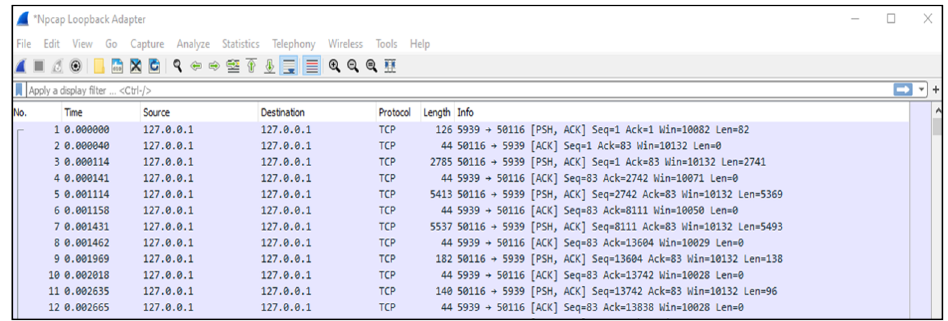
Figure 13. IoT Devices connected to the home network using IP scanner.